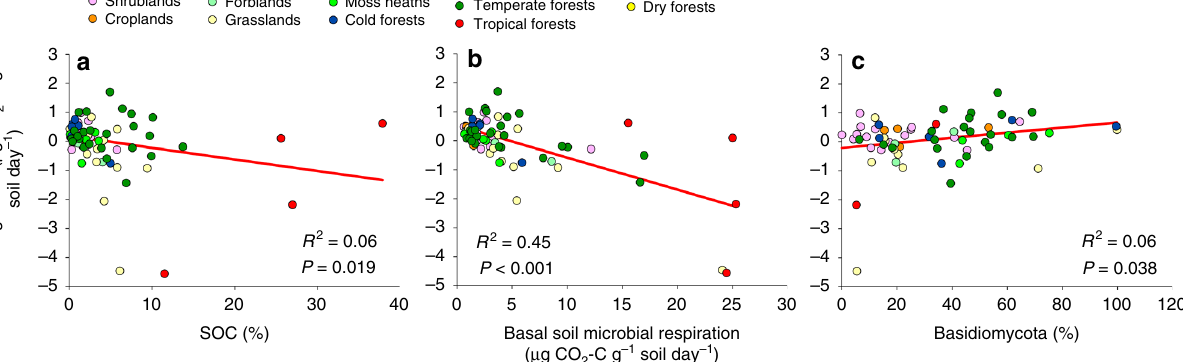
Fig. 3 Selected relationships from SEM between the apparent priming effect and different variables. a Apparent priming vs soil organic C (SOC) content. b Apparent priming vs basal microbial respiration. c Apparent priming vs the relative abundance of Basidiomycota. Colour symbols represent ecosystem types. All relationships are signi fi cant ( p <